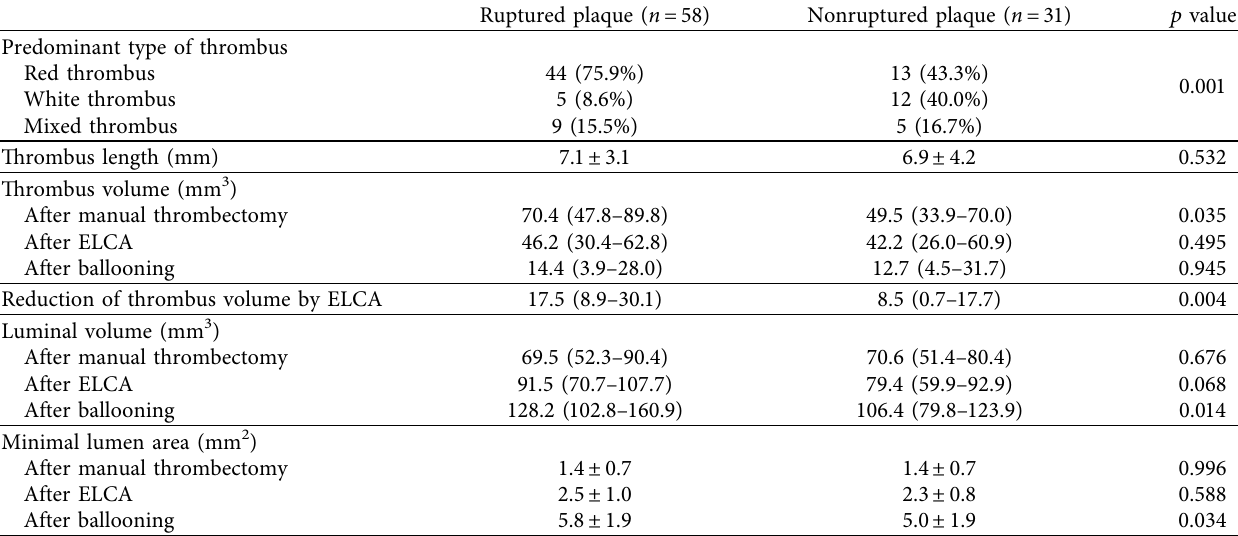
Table 4: Comparison between ruptured and nonruptured plaque.